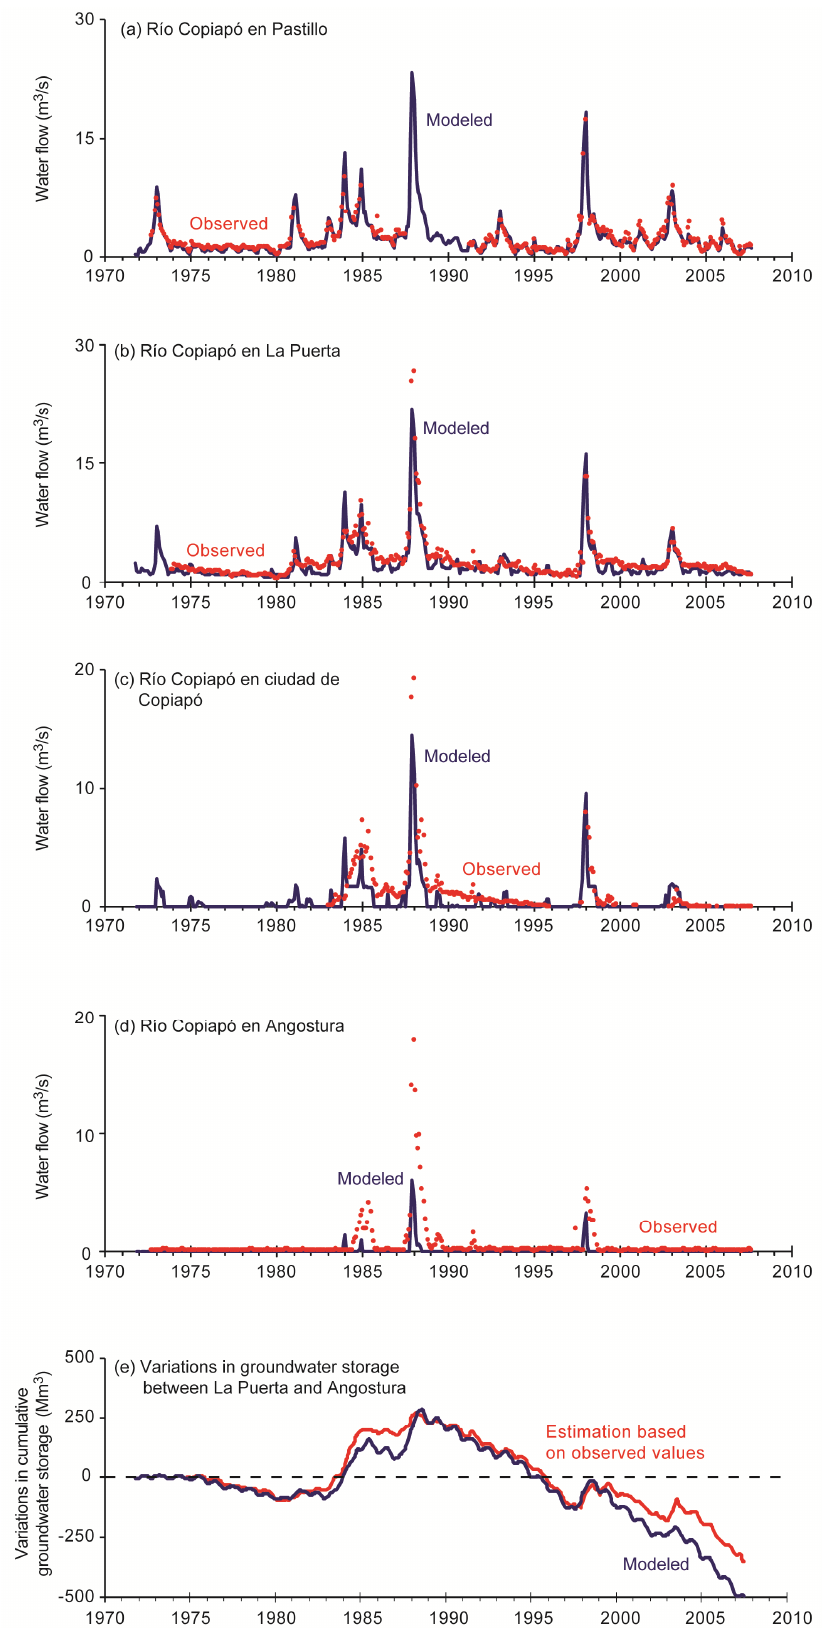
Figure 4. Results from the calibration process in the Copiapó River basin. ( a )–( d ) Stream flows at selected fluvial stations; ( e ) Cumulative fluctuations in the aquifer’s storage volume. The reference (null) volume corresponds to